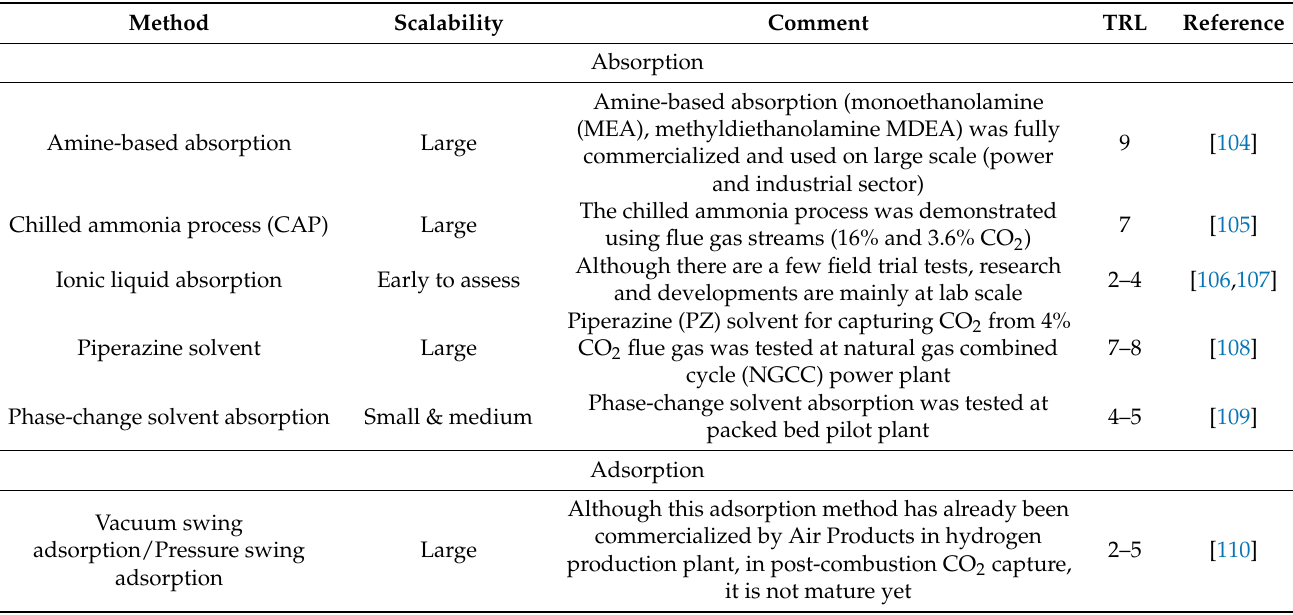
Table 4. Scalability and TRL performances of CO 2 capture